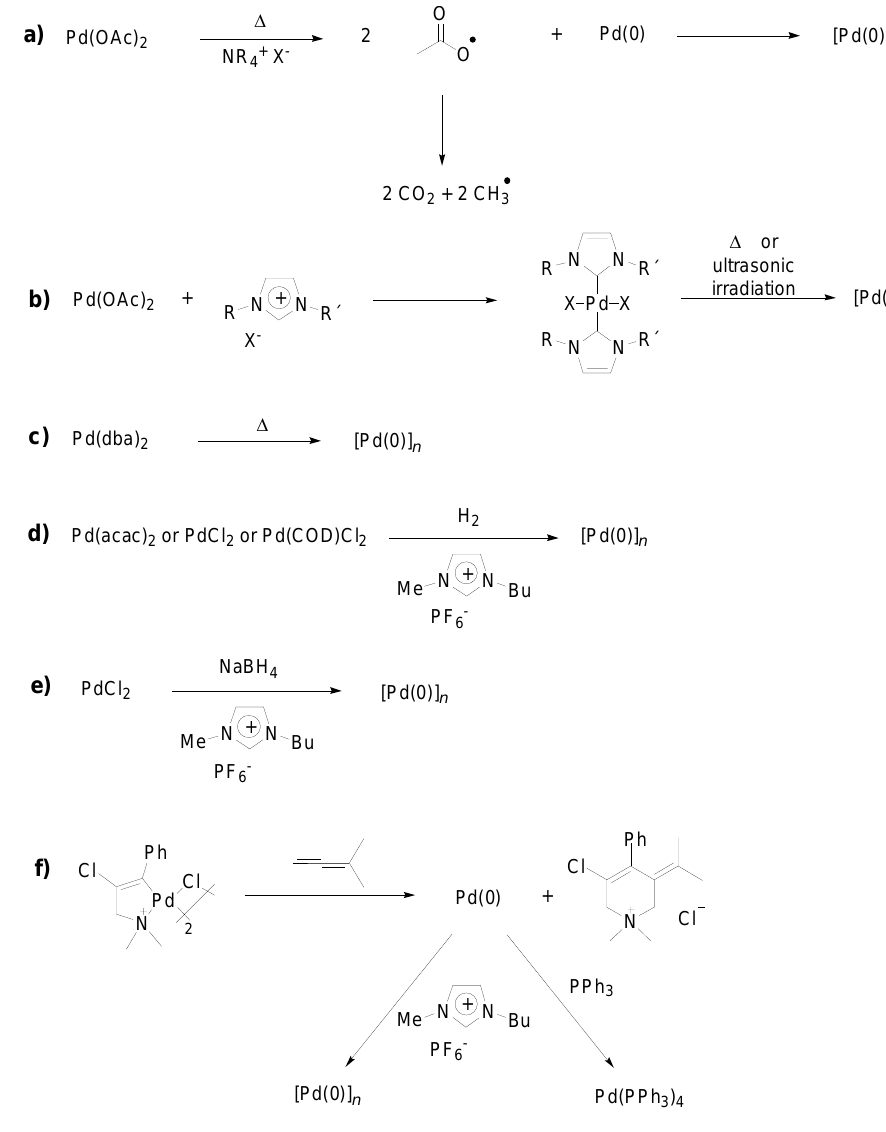
Scheme 1. Pd-NPs synthesis in ILs by thermal or ultrasonic decomposition of palladium ), reduction with hydrogen gas or hydrides salts and complexes (Top: a-c; X = halide or BF 4 (Middle: d-e) or reductive elimination of a palladacycle by reaction with a diene (Bottom: f). Adapted from references